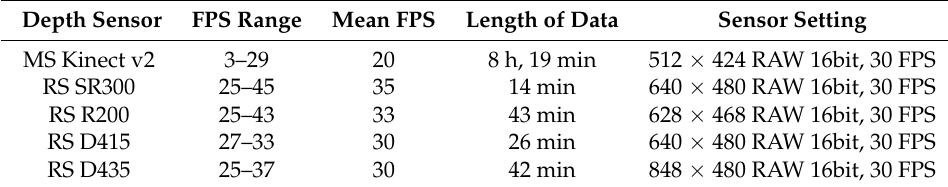
Table 1. Depth data